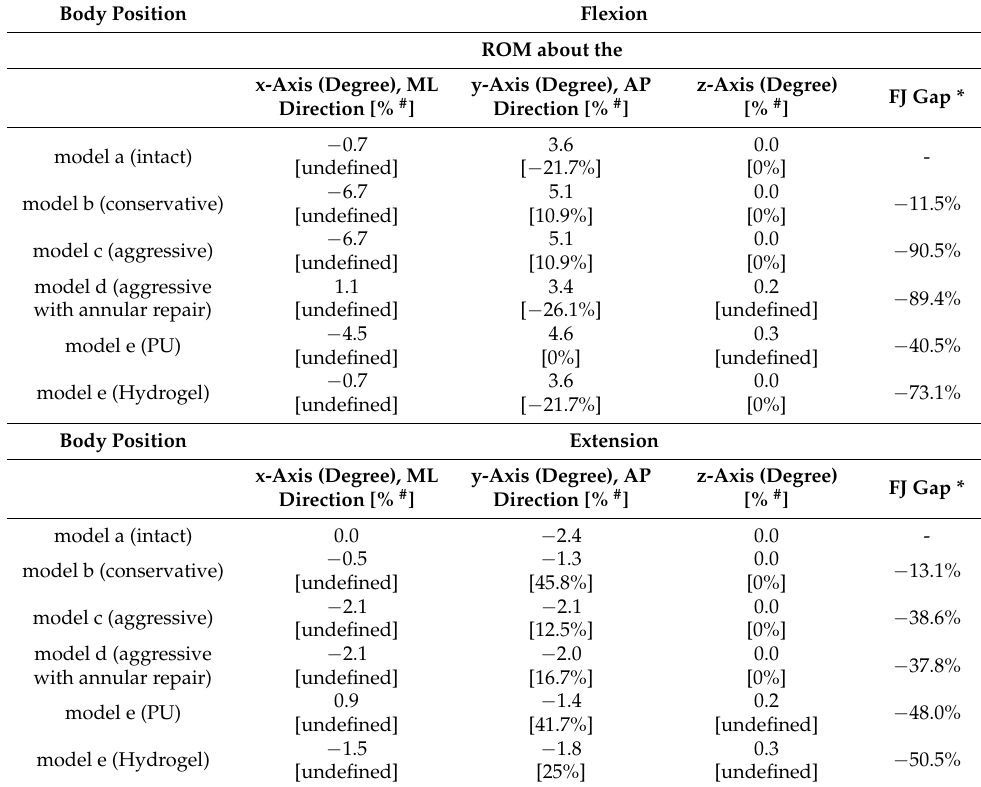
Table 3. ROM and FJ gap in each model when moved through different motions.